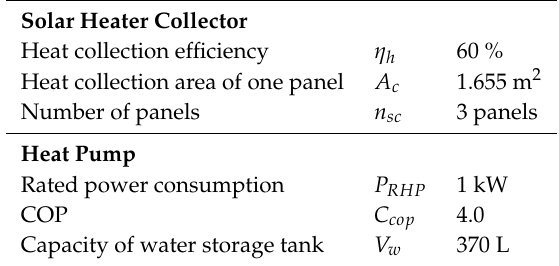
Table 1. Specification of solar collector (SC)